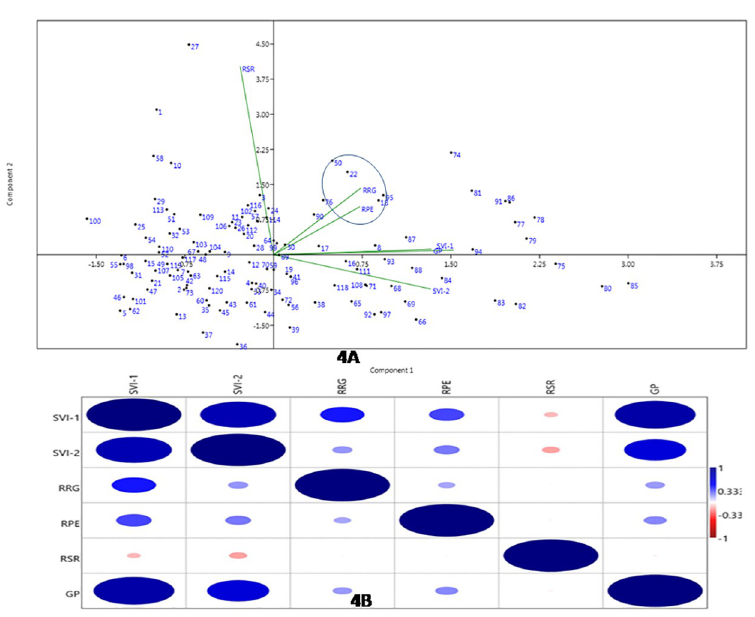
Fig 4. (A) Genotype-by-trait bi-plot diagram showing 120rice landraces in two PCs for 6 physiological traits (B) Heat map showing Pearson’s correlation coefficients for physiological traits. The dot numbers in the diagram depict the serial number of the germplasm line listed in Table 1. Significant correlations are colored either in red (negative correlation at 0.01 level) or blue hues (positive correlation at 0.01 level).